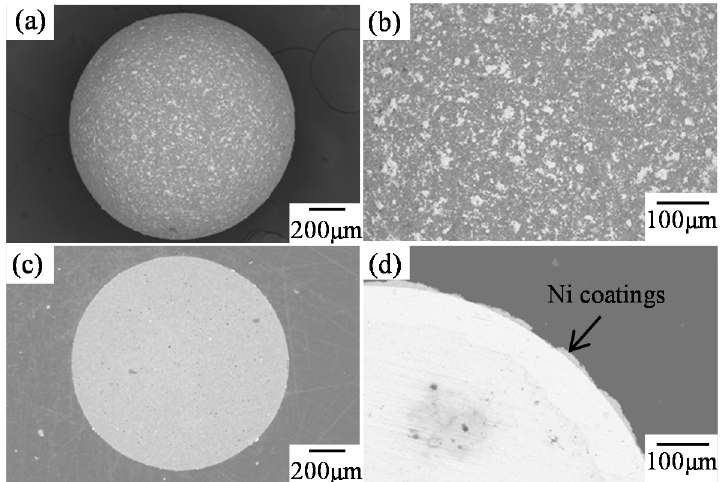
Figure 9. Ni coatings by MCT at 480 rpm for 26 h. ( a , b ) Surface structure; ( c , d ) Cross sectional